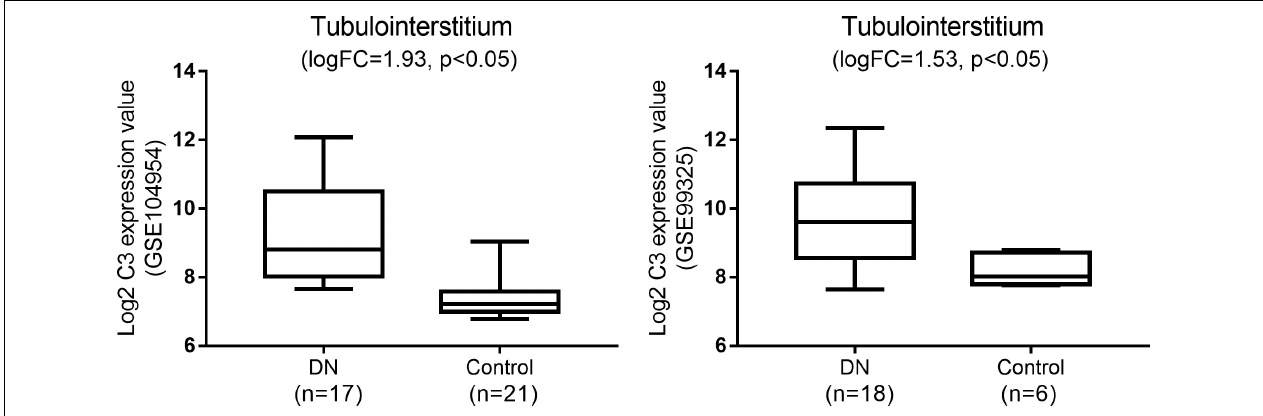
FIGURE 3 | Gene expression omnibus validation: the expression of C3 in diabetic nephropathy (DN) when compared with normal tissues in the GSE104954 and GSE99325 datasets.